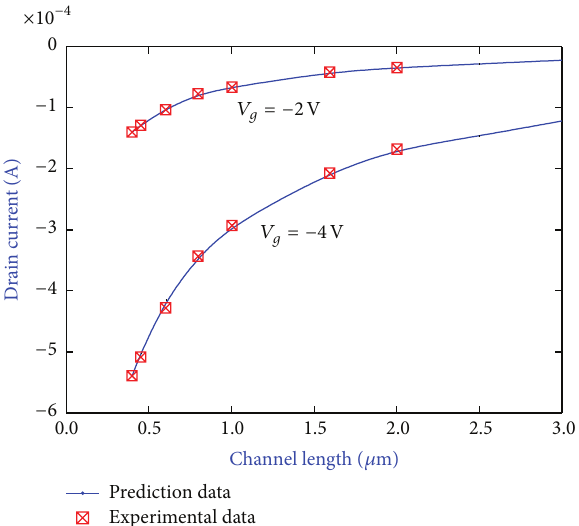
Figure 8: Comparison of 𝑔 measured results and prediction data ds ofthegroup1Bdiagnosticsamples(as 𝐿 = 0.5 ,1.2,3- 𝜇 m; 𝑉 𝑔 = −3